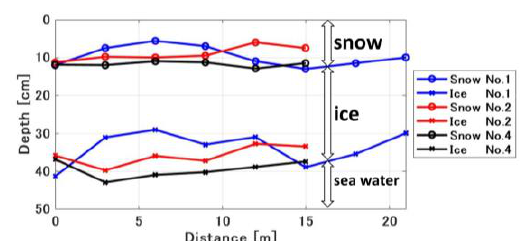
Figure 7. Snow and ice depth from snow surface obtained by the direct measurement along GPR survey